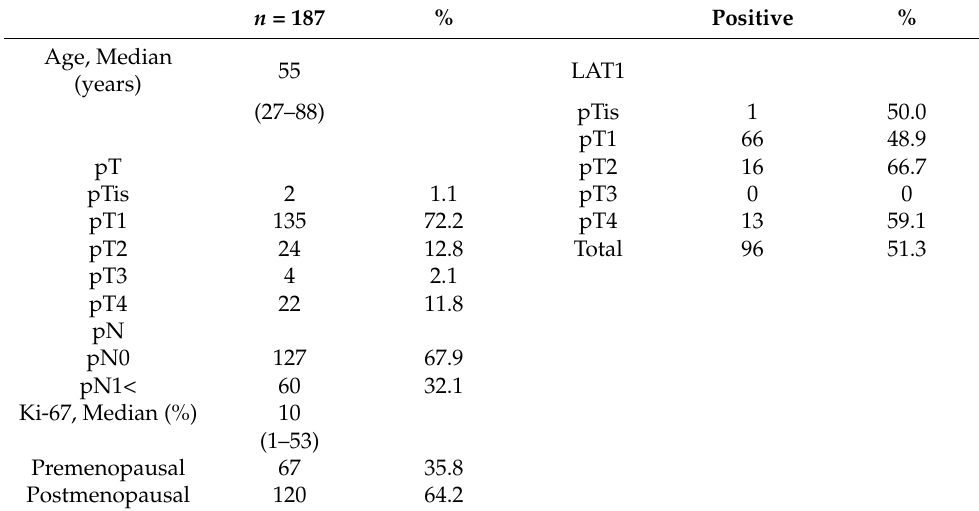
Table 1. Clinicopathological characteristics of ER-positive breast cancer patients (Cohort 1).